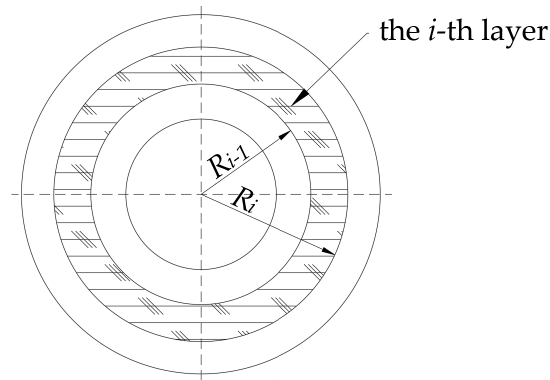
Figure 2. Illustration of the inner and outer radii on the i -th layer in the composite boring